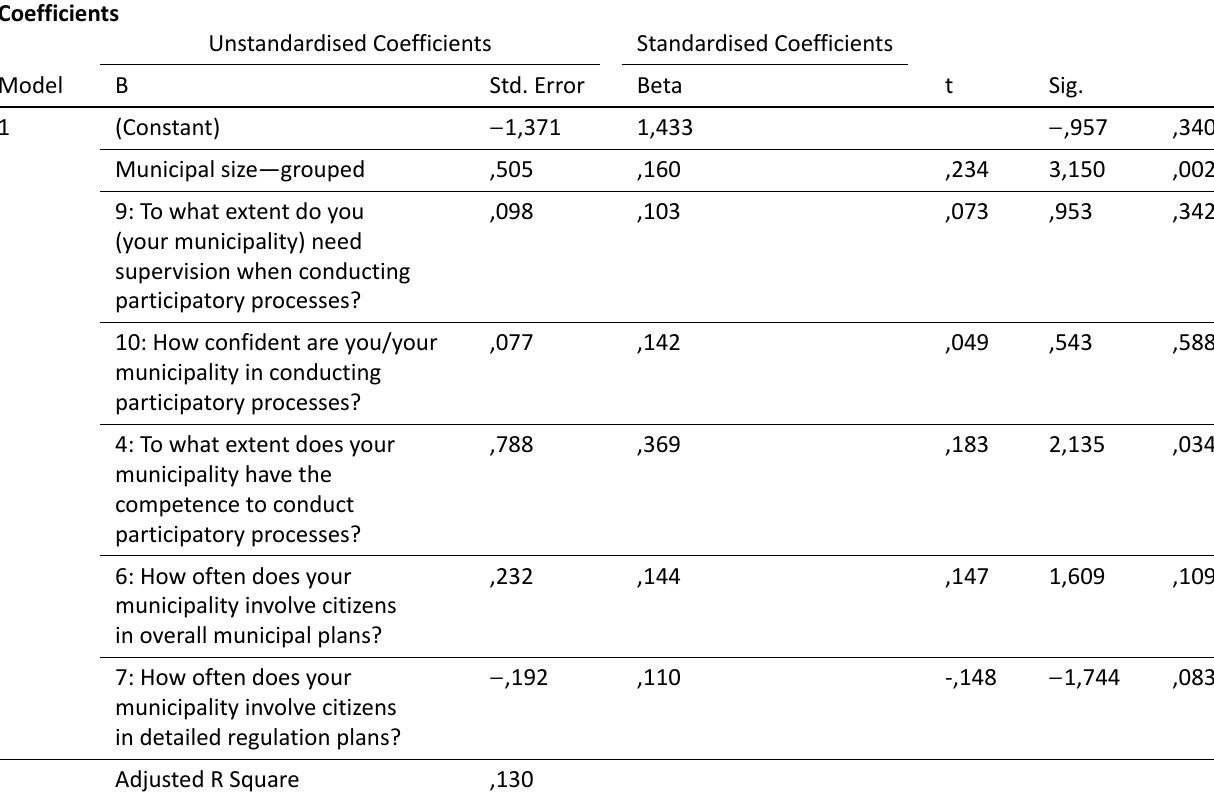
Table 1. OLS regression analyses of the use of the children track method. Source: Barnetråkk (children’s